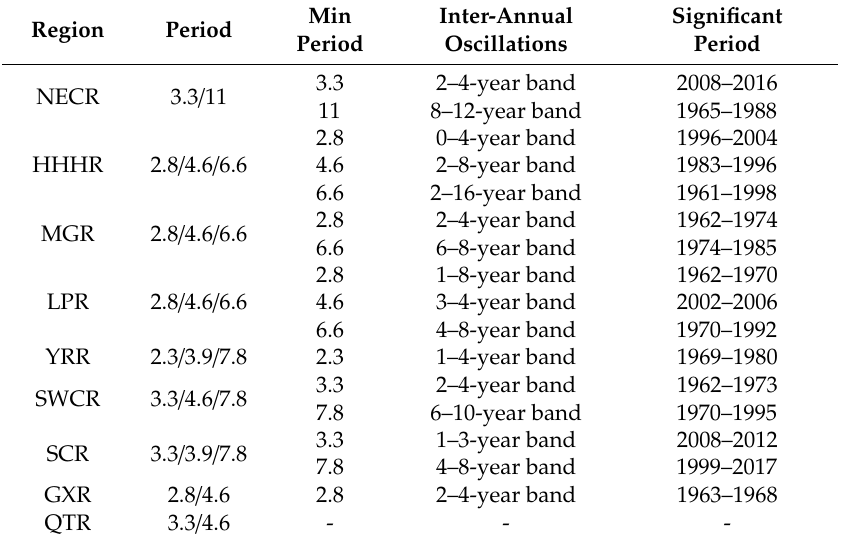
Table 4. Periodic oscillation of the nine agricultural regions and the entire China during